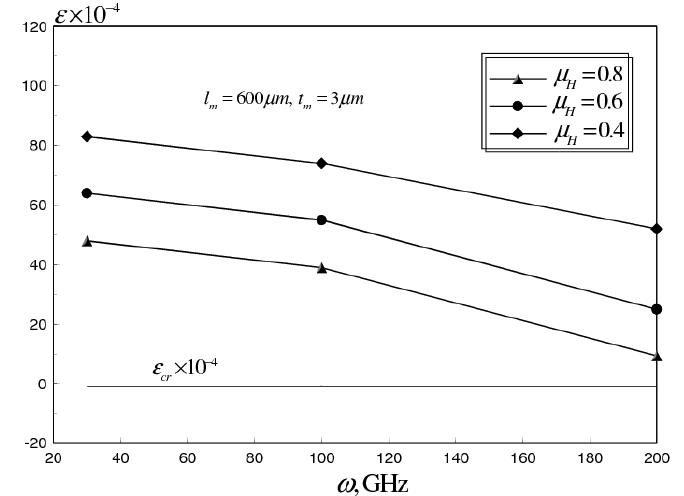
) on average axial strain of corrugated aluminum H